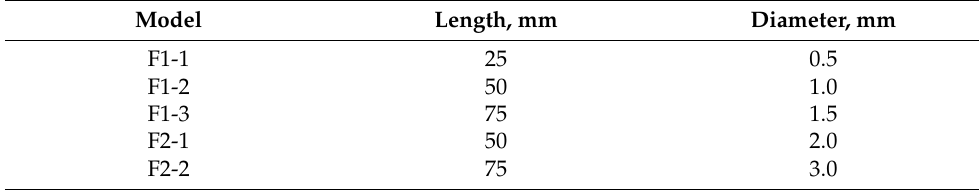
Table 2. Dimensions of fibers.